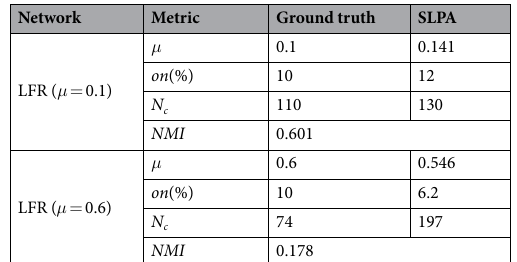
Table 3. μ is the estimated mixing parameter. on is the proportion of the overlapping nodes. N c the number of communities membership. NMI is the Normalized Mutual Information shared by the two community structure (ground truth, uncovered by SLPA).